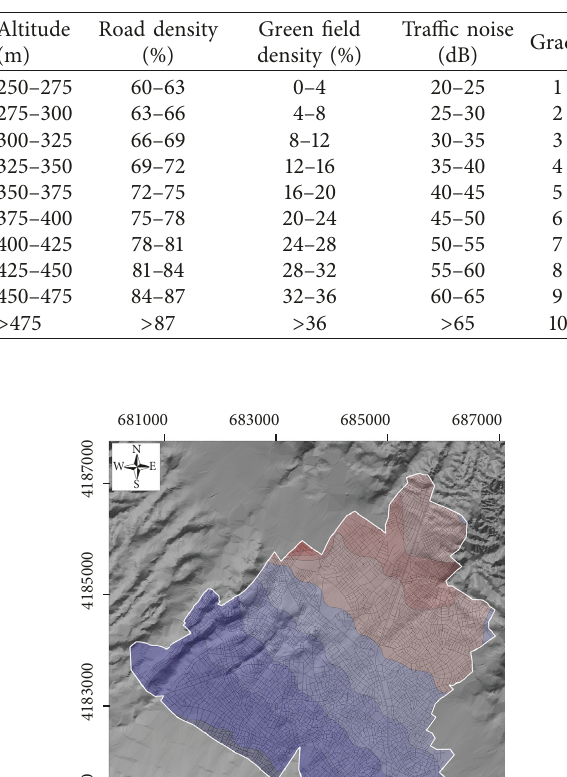
Table 1: Considered parameters and grading.